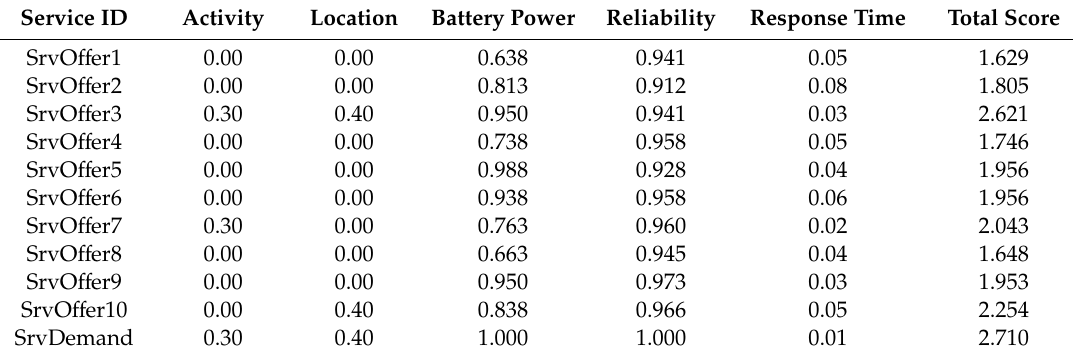
Table 6. Scores calculated through Bandara approach [14].